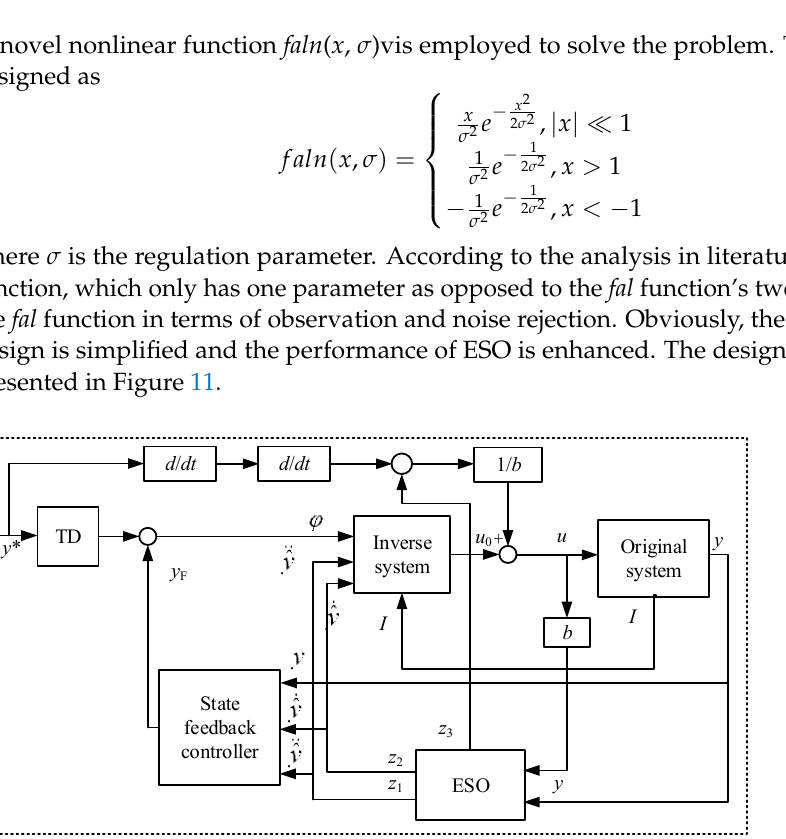
Figure 11. Improved topology of ADRC.